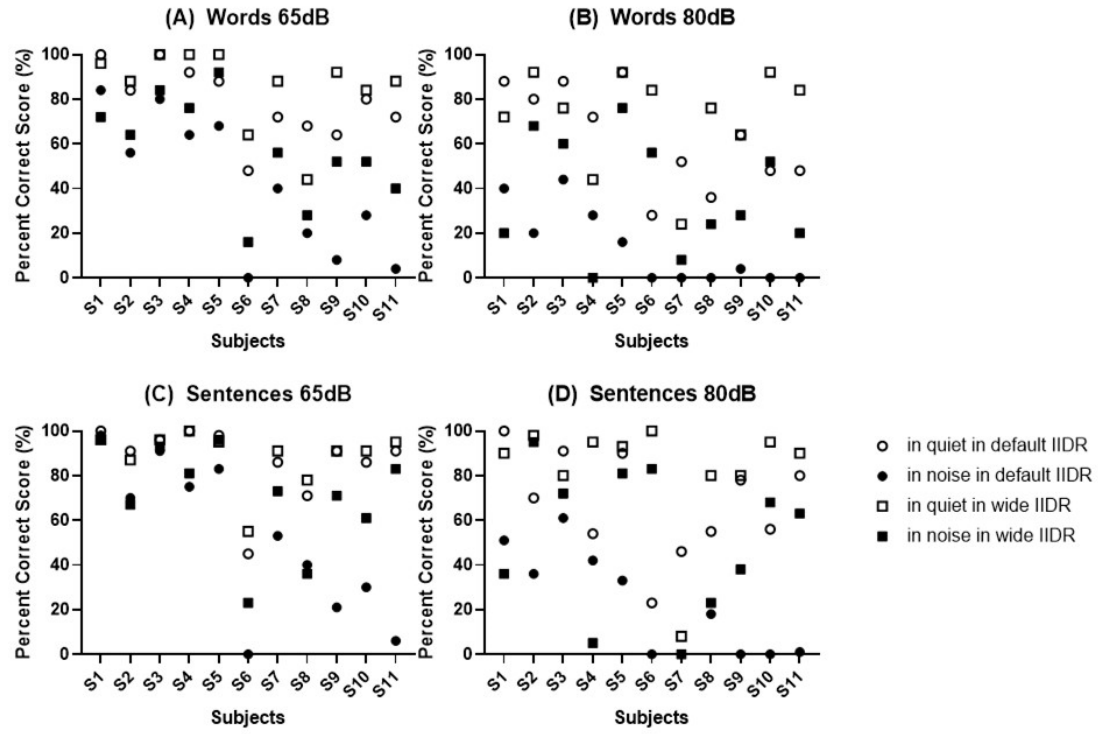
Figure 2. Individual scores for each test type and presentation level. ( A ) Word test at 65 dB, ( B ) word test at 80 dB, ( C ) sentence test at 65 dB, and ( D ) sentence test at 80 dB.